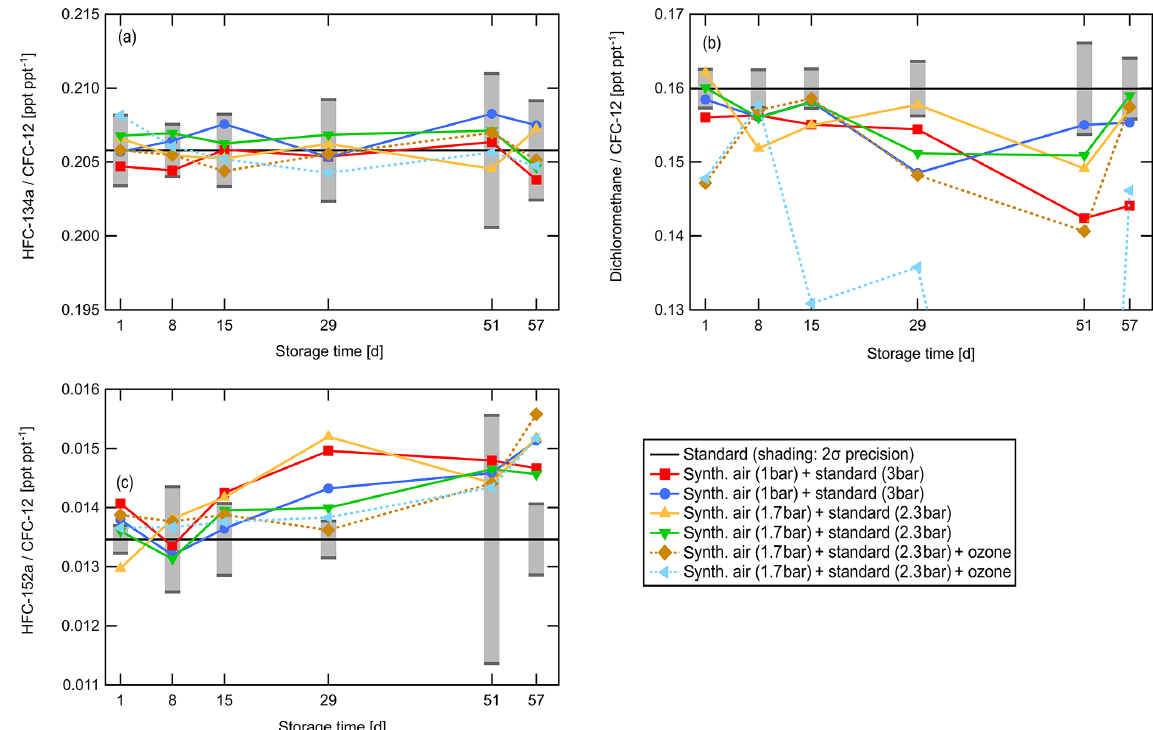
Figure 4. Results of the ozone and long-term storage test for HFC-134a (a) , dichloromethane (b) , and HFC-152a (c) . The ratio of the mixing ratio of the respective compound relative to that of CFC-12 to cancel dilution uncertainties is shown. For dichloromethane the vertical scale has been adjusted, cutting off samples that were strongly depleted. The solid black line represents the value expected from direct measurements of the standard gas and the synthetic air. Shading indicates the 2 σ experimental uncertainty range around the expected value; error bars of individual data points are omitted for clarity. Colours represent groups of canisters which were simultaneously filled with the gas mixture indicated in the legend. On each measurement day, one canister in each group was